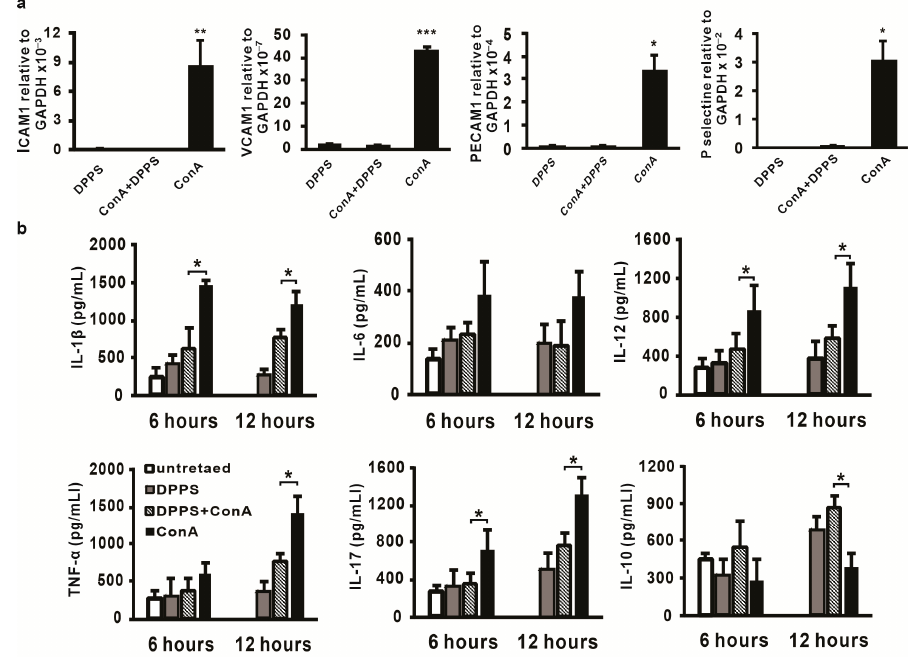
Figure 5. DPPS attenuates liver inflammation induced by ConA. ( a ) ICAM-1, VCAM-1, PECAM-1, and P-selectine mRNA expression in livers determined using real-time qRT-PCR with GPADH mRNA as an internal control, 12 h after infection ( n = 5) presented as mean + SE. ( b ) Concentration of IL-1 β , IL-6, IL-12, IL-17, TNF- α , and IL-10 in the liver tissue homogenate 6 and 12 h after ConA injection determined by ELISA presented as mean + SD (*** p < 0.001; ** p < 0.005; * p < 0.05).